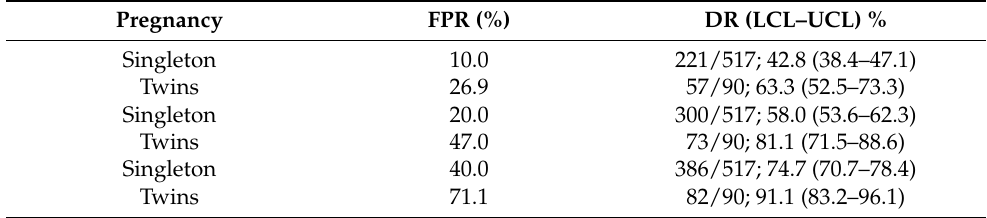
Figure 1. Odds ratio for gestational diabetes mellitus according to maternal factors and chorionicity. The odds ratio for each type of twin pregnancy refers to a woman who is 35 years old, 69 kg in weight, 164 cm in height, is of White racial origin, conceived naturally, has no family history of diabetes, and is nulliparous. Table 3. Performance of screening for gestational diabetes mellitus in singleton and twin